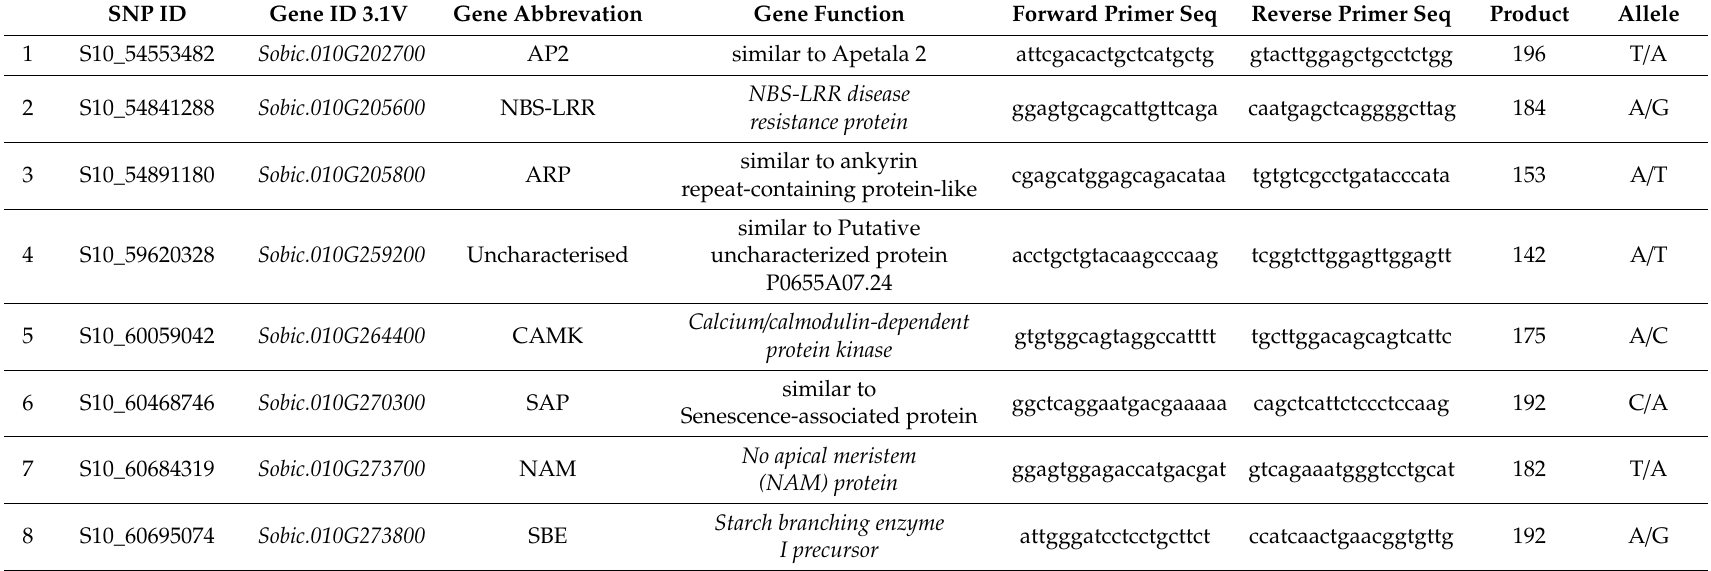
Table 6. Primers designed for candidate gene expression